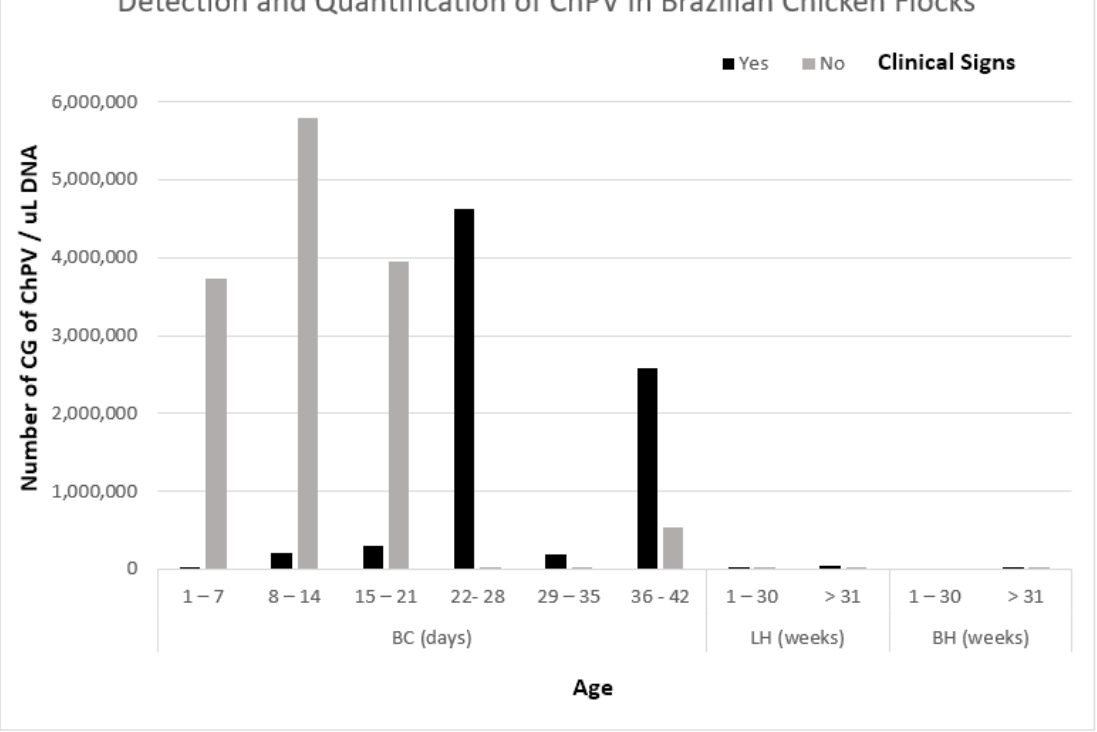
Figure 2. Detection and quantitation of ChPV using the sensitive fast-qPCR based on SYBR ® Green. ChPV = Chicken Parvovirus; BC = Broiler Chickens; LH = Layer Hens; BH = Breeder Hens; CG = Copies of Genome.